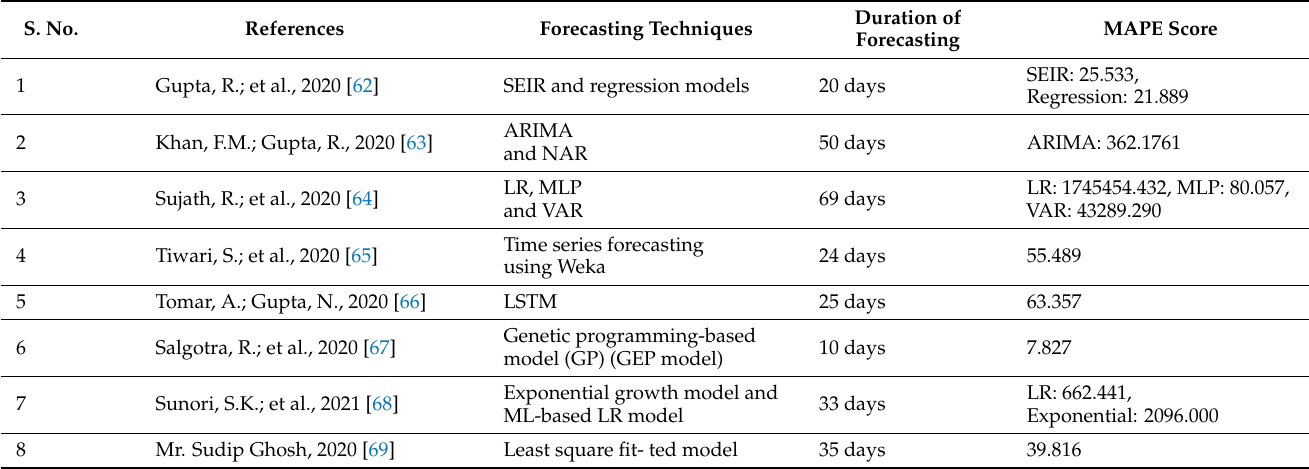
Table 3. Some previously reported forecast accuracy